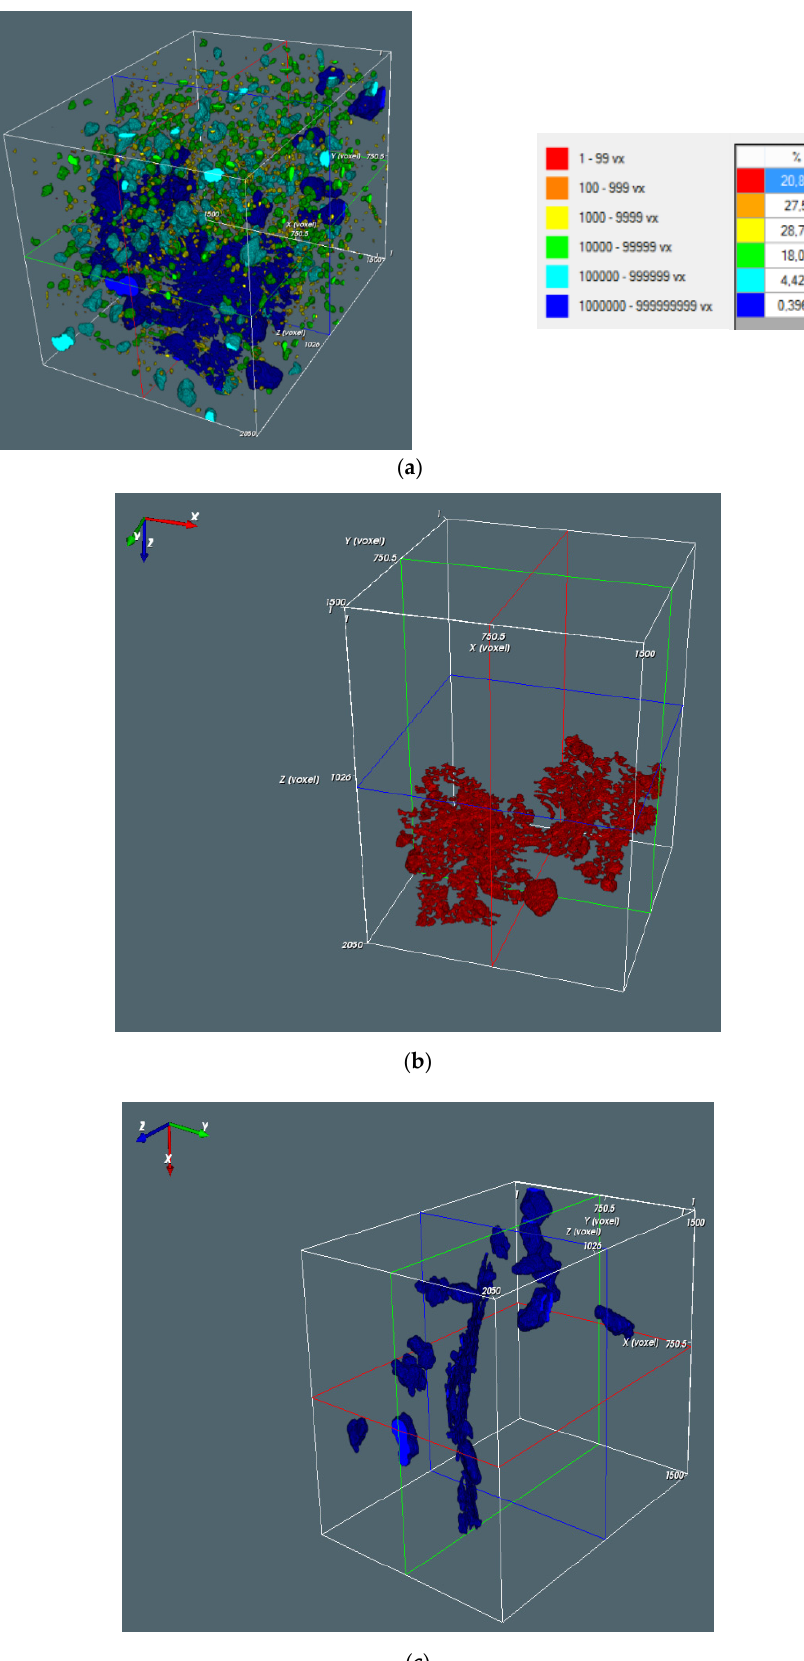
Figure 14. ( a ) Micro-CT image of the full clayey limestone samples and object size classification, Y-Z plane. Colors: red: 1–99 voxels; orange: 100–999; yellow: 1000–9999; green: 10,000–99,999; light blue: 100,000–999,999; dark blue: above 1,000,000 voxels. Scale: 1 voxel = 0.6 × 0.6x × 0.6 μ m 3 . ( b ) Micro-CT image of the largest fracture in the clayey limestone sample, object size classification, Y-Z plane. Red color refers to the object selection; description as in Figure 14(a). Scale: 1 voxel = 0.6 × 0.6 × 0.6 μ m 3 . ( c ) Micro-CT image of the objects with a volume above 1,000,000 voxels (without the largest object visible in the Figure 14(b)) in the clayey limestone sample, object size classification, X-Z plane. Colors are the same as in Figure 14(a). Scale: 1 voxel = 0.6 × 0.6 × 0.6 μ m 3 . Fracture is a characteristic object distinguished in the sample. It was characterized on the basis of parameters calculated using the poROSE program. Fracture occupied only 0.3968% of the sample. The fracture volume constituted 13.89% of the volume of the 3276 porous objects selected in the sample under the micro-CT/poROSE analyses. The effective